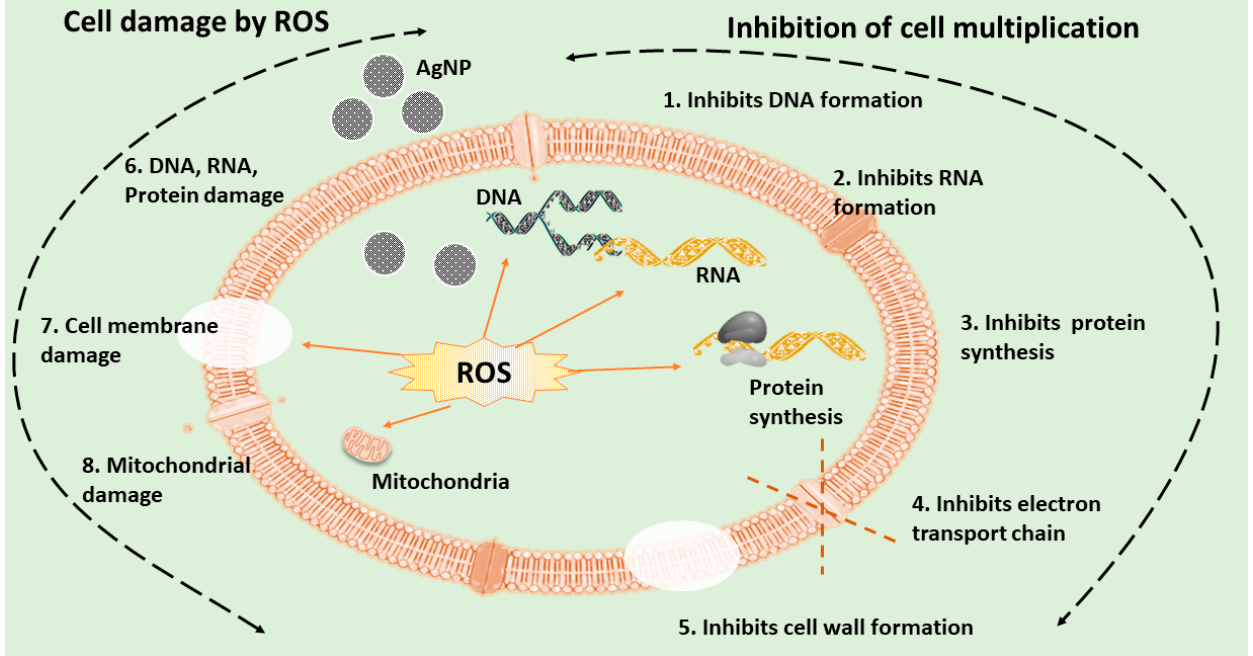
Figure 4. Various hypothetical mechanisms followed by AgNPs to inhibit bacterial cell multiplication and cause bacterial cell damage by ROS. Mechanisms 1–5 are followed to inhibit cell multiplication, and Mechanisms 6–8 cause cell